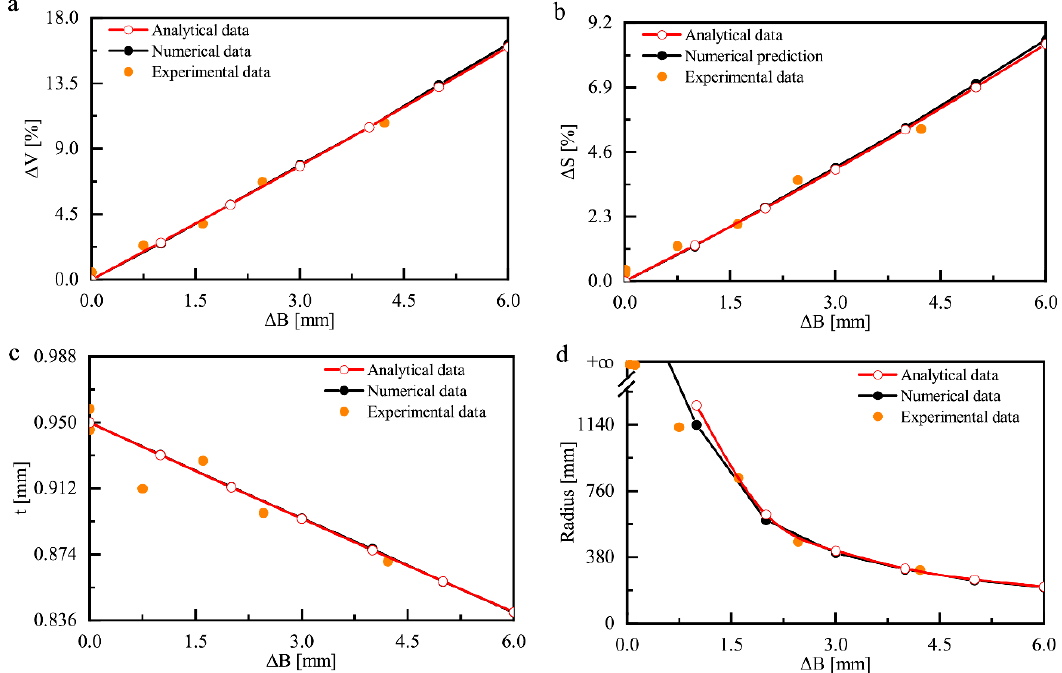
Figure 18. Plots of volume increment ( a ), area increment ( b ), minimum thickness ( c ), and meridian radius ( d ) versus the bulging magnitude of the bi-segment bulged hulls.